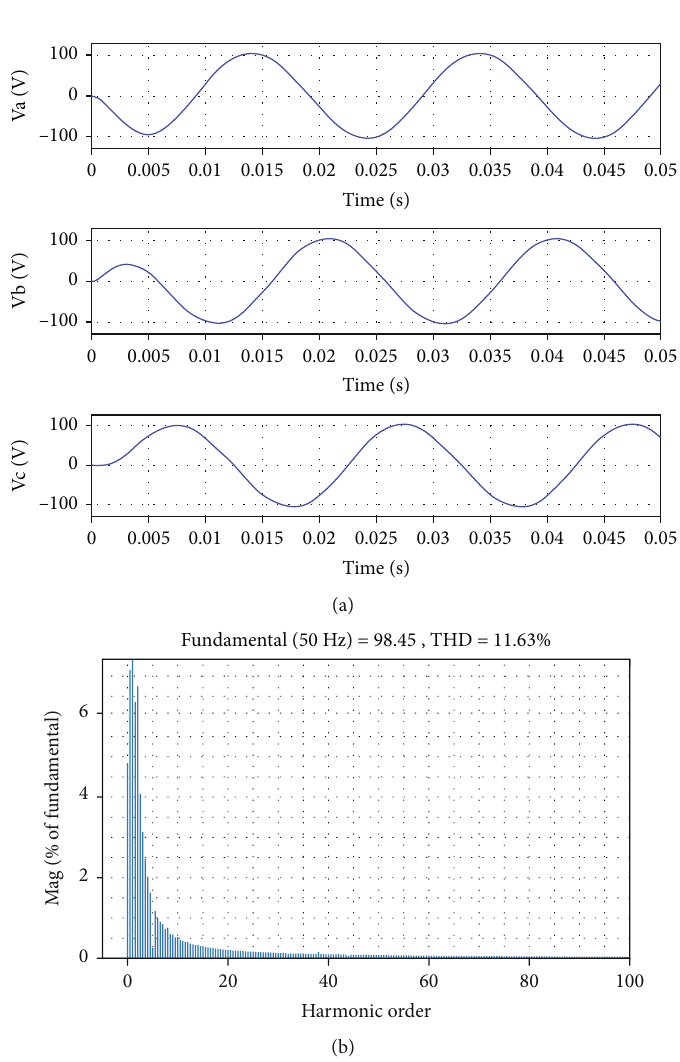
V V an , bn , and cn ) and spectrum of